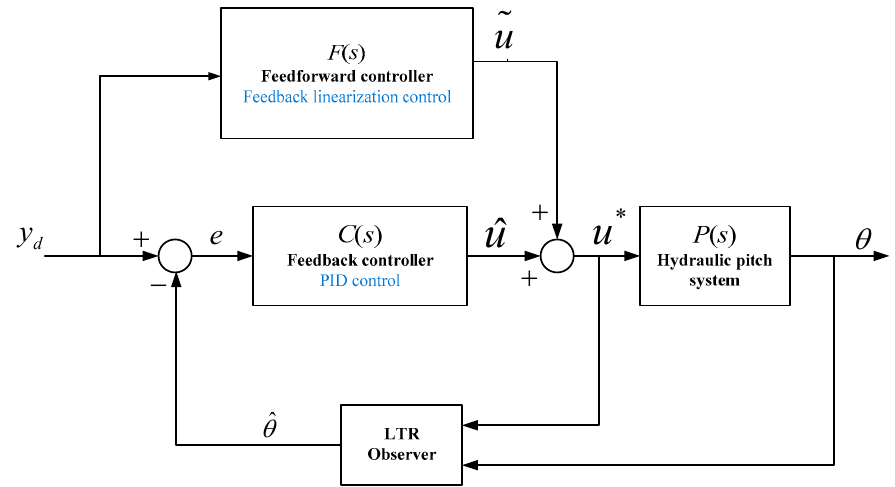
Figure 6. Block diagram of standard two degree-of-freedom (2-DOF) controller in motion system.